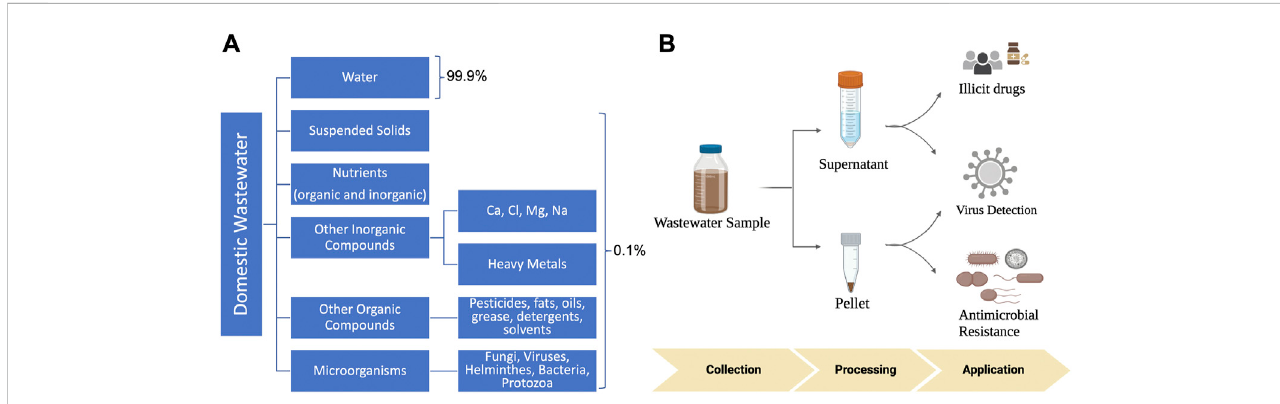
FIGURE 1 (A) Wastewater surveillance for public health. (A) Constituents of wastewater. Wastewater is mostly composed of water (~99.9%), with .1% of solids, nutrients, organic, and inorganic compounds, and microorganisms. (B) Applications of wastewater in public health. Wastewater sample is collected and processed, with the resulting supernatant and pellet being utilized to detect and quantify human pathogens, illicit drugs, and antimicrobial